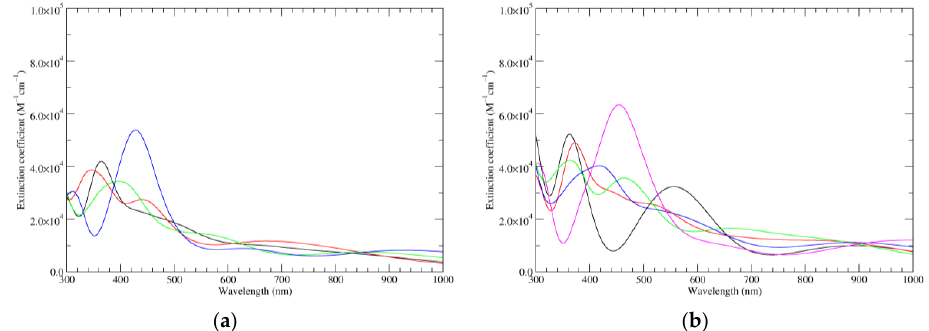
Figure 7. Computed UV–Vis spectra of the most significant tautomers/conformers in the four-electrons oxidation state. ( a ) Neutral form in vacuo: black line, a16_b6_c6_d0, C 1 , conf1; red line, a6_b16_c6_d0,